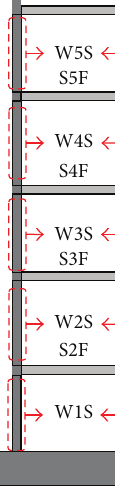
Figure 5: Updating parameters for initial analytical